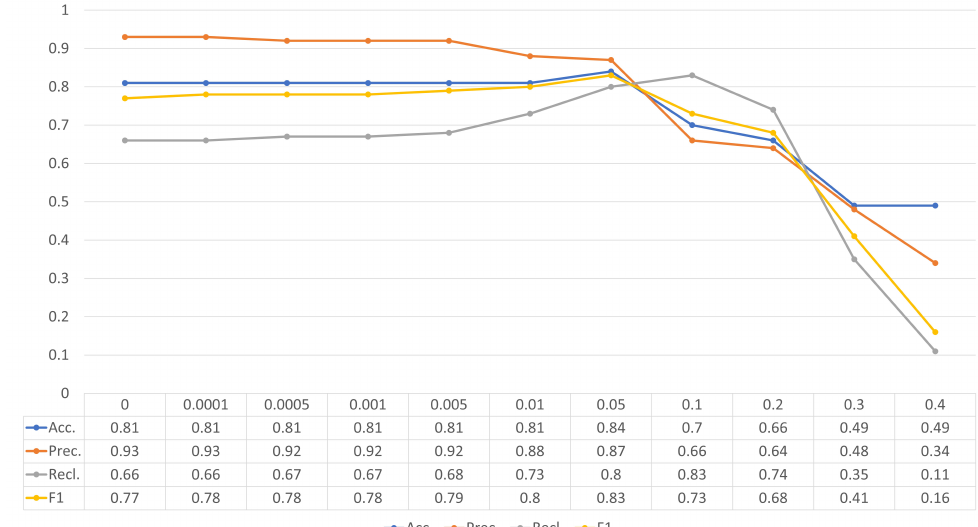
Figure 4. CNN experiments detailed results.